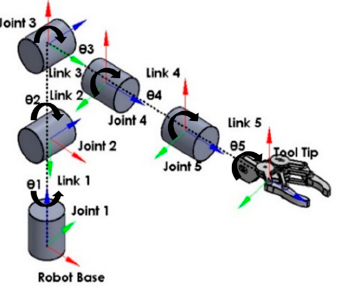
Figure A1. Kinematic Diagram of TAL BRABO Manipulator.